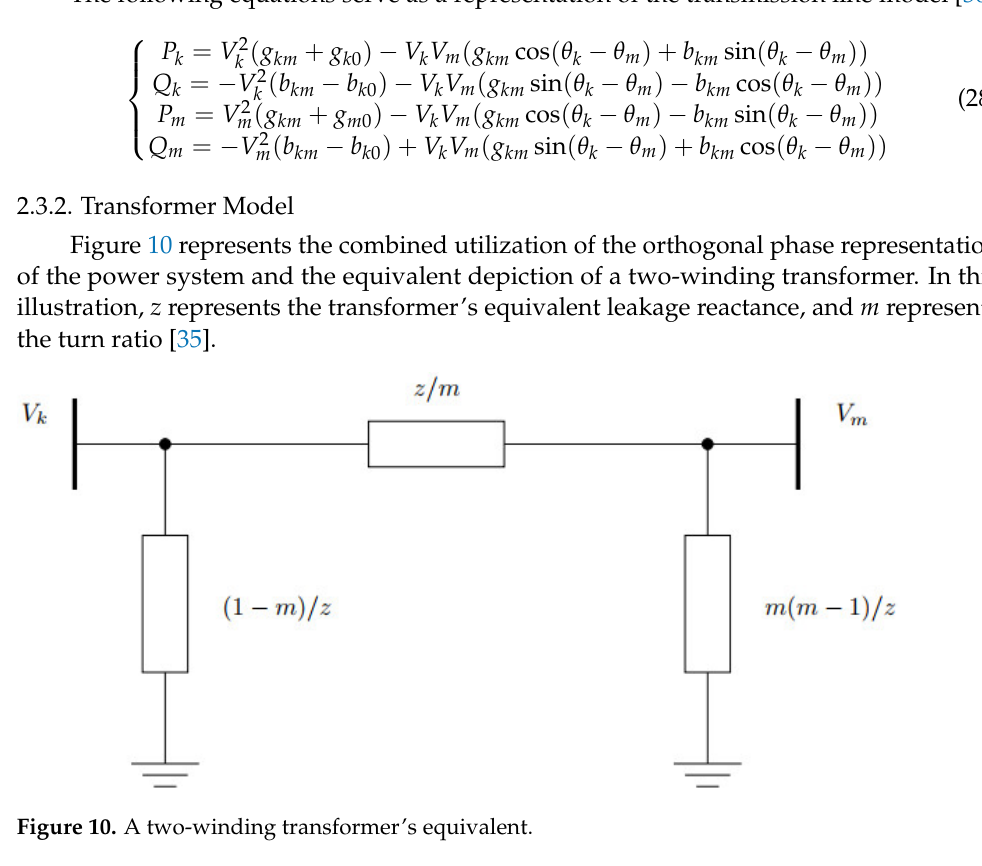
Figure 11. Modeled representation of load.